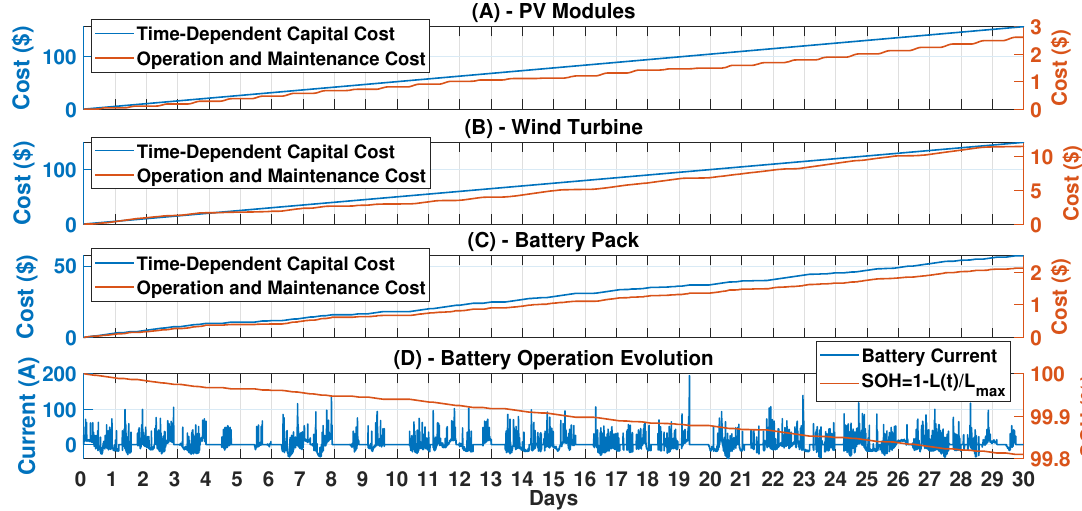
Figure 8. Time-dependent capital cost and O & M cost of the PV array ( A ), the wind turbine ( B ), the battery bank ( C ) and SOH and battery current profile ( D ) referring to the snapshot of simulation reported in Figure